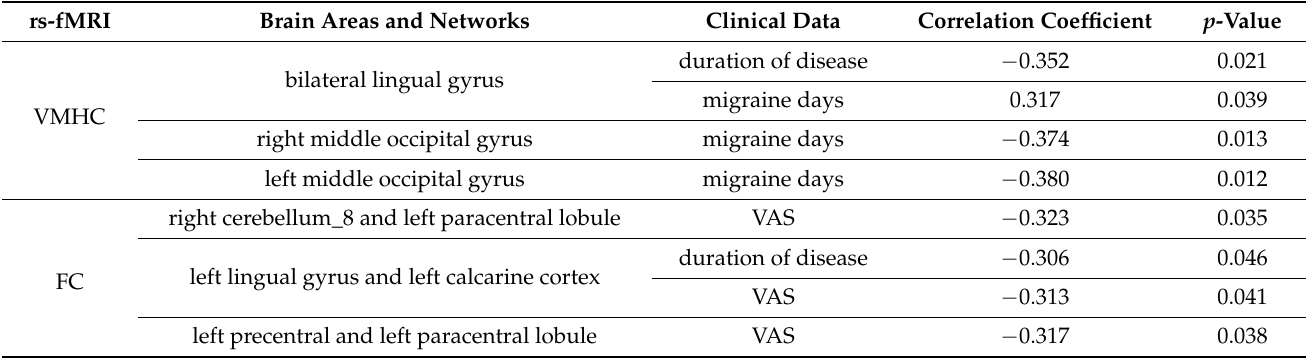
Table 4. Correlations between clinical parameters in female MwoA patients and VMHC and FC values in the abnormal bran regions and networks between female MwoA patients and HCs. rs-fMRI Brain Areas and Networks Clinical Data Correlation Coefficient p